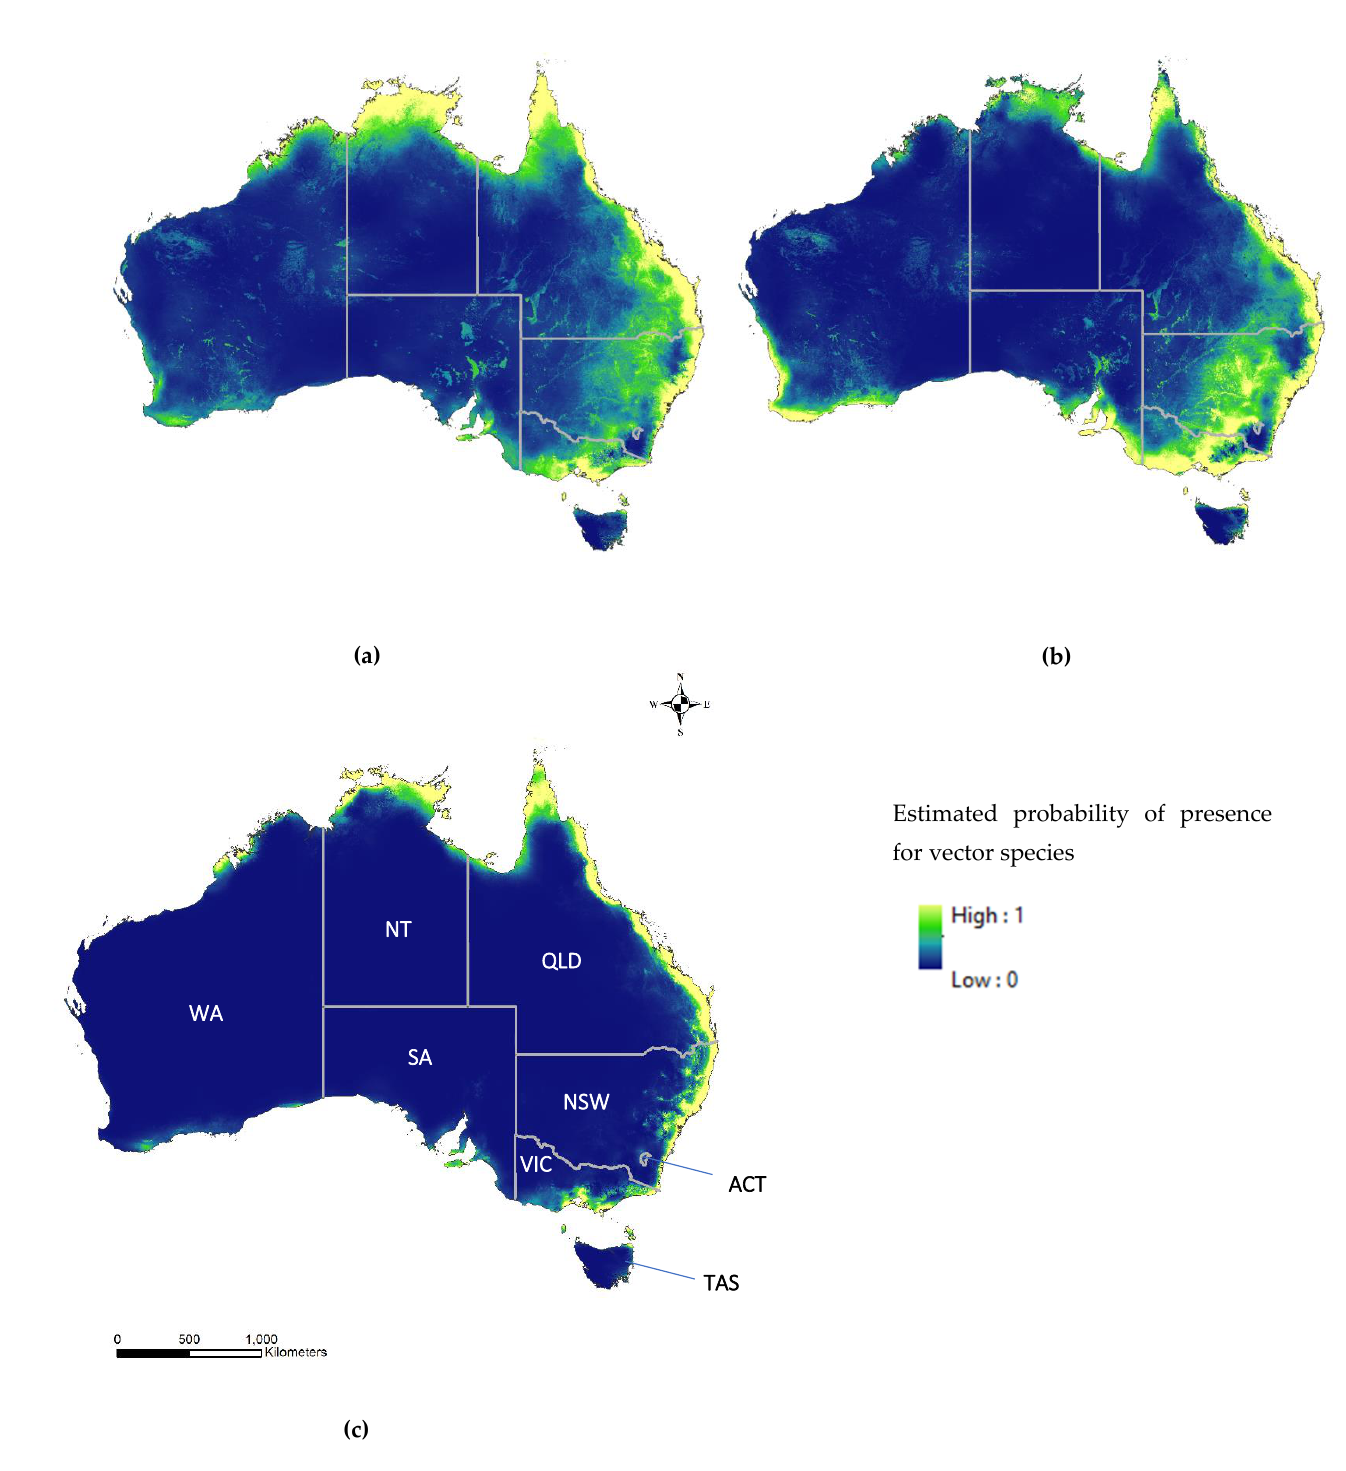
Figure 1. Ecological niche models for ( a ) Cx. annulirostris , ( b ) Cx. quinquefasciatus and ( c ) Cx. sitiens estimated using the cloglog transformation in Maxent. Colours represent the continuous probability of mosquito presence where blue is very low and yellow is high. States are labelled by their abbreviated names in figure ( c ) were NT = Northern Territory, QLD = Queensland, NSW = New South Wales, ACT = Australian Capital Territory, VIC = Victoria, TAS = Tasmania, SA = South Australia and WA = Western Australia.